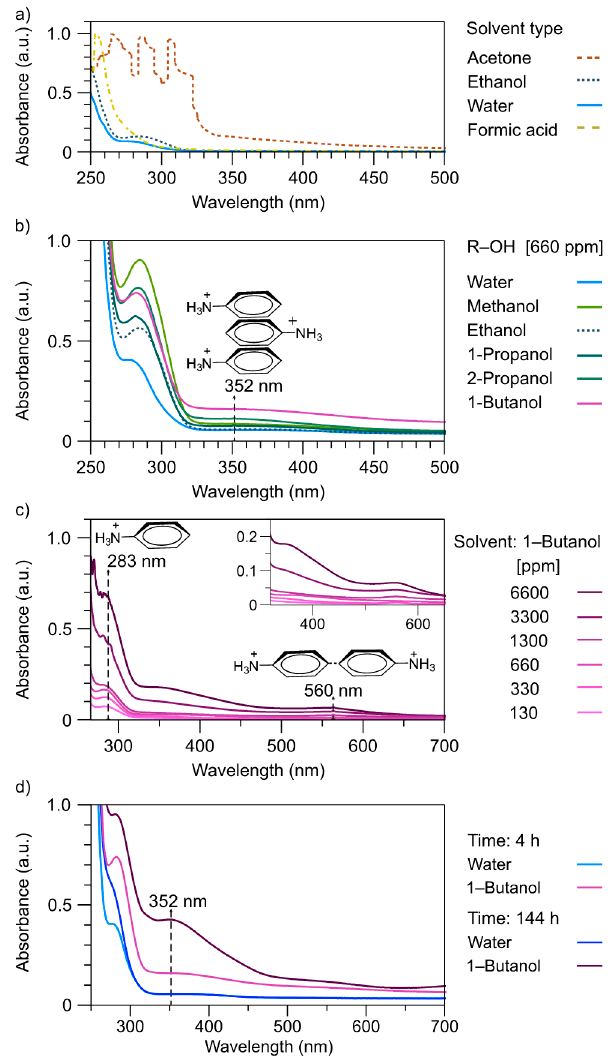
Figure 8. UV-Vis spectra of Poly(Ani-AMPS) in ( a ) different solvents, ( b ) different alcohols, ( c ) different concentrations for 4 h, ( d ) different times (4 and 144 h) at a concentration of 660 ppm.